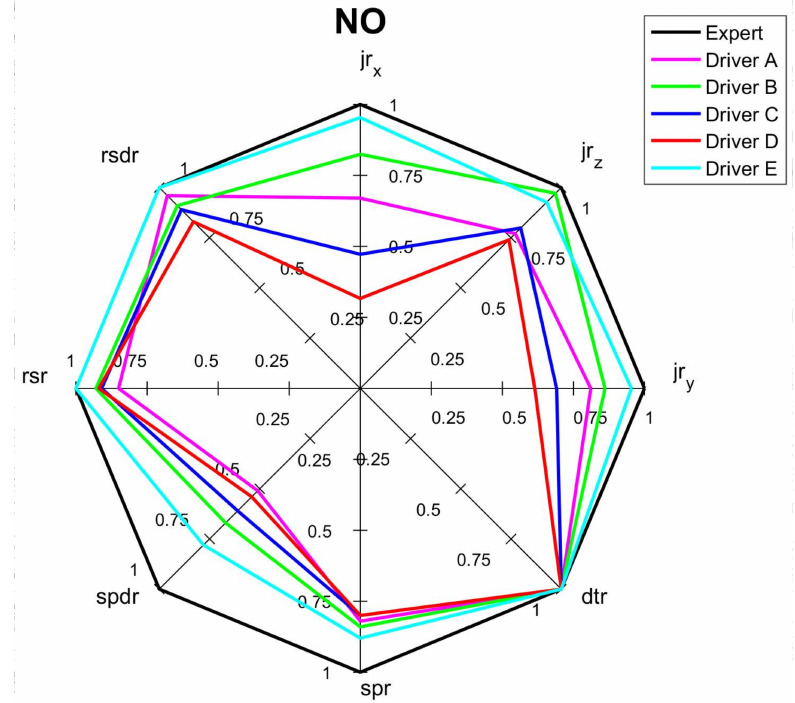
Figure 13. Spider diagram for overall scores ( dtr indicator is not distinct due to short time of the